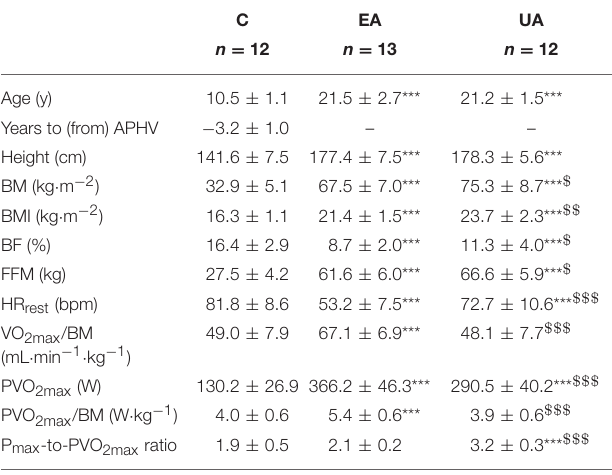
TABLE 1 | Participants’ physical